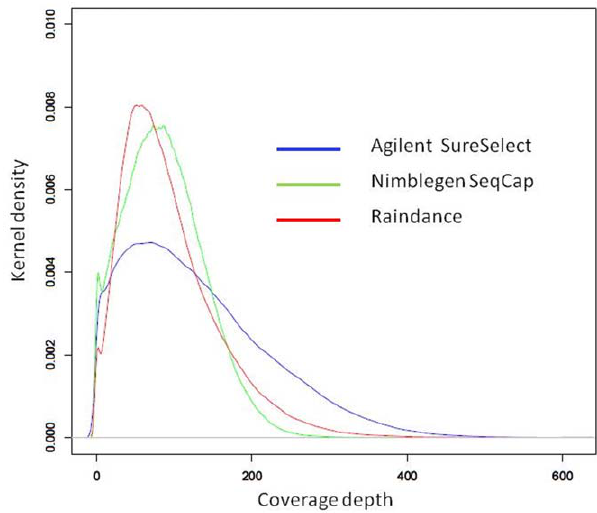
Figure 3. Kernel density of coverage depth. Depicts kernel density function for the three enrichment platforms studied. The set of coverage depth values at each target position were pooled across all individuals from the matched sample set and the frequency of values at each depth were used to calculate the density function.